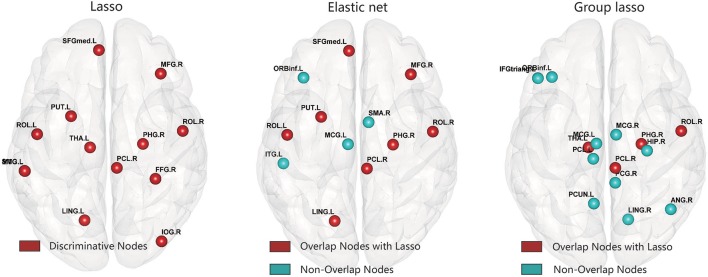
Abnormal brain regions were mapped onto the cortical surfaces using BrainNet viewer software.